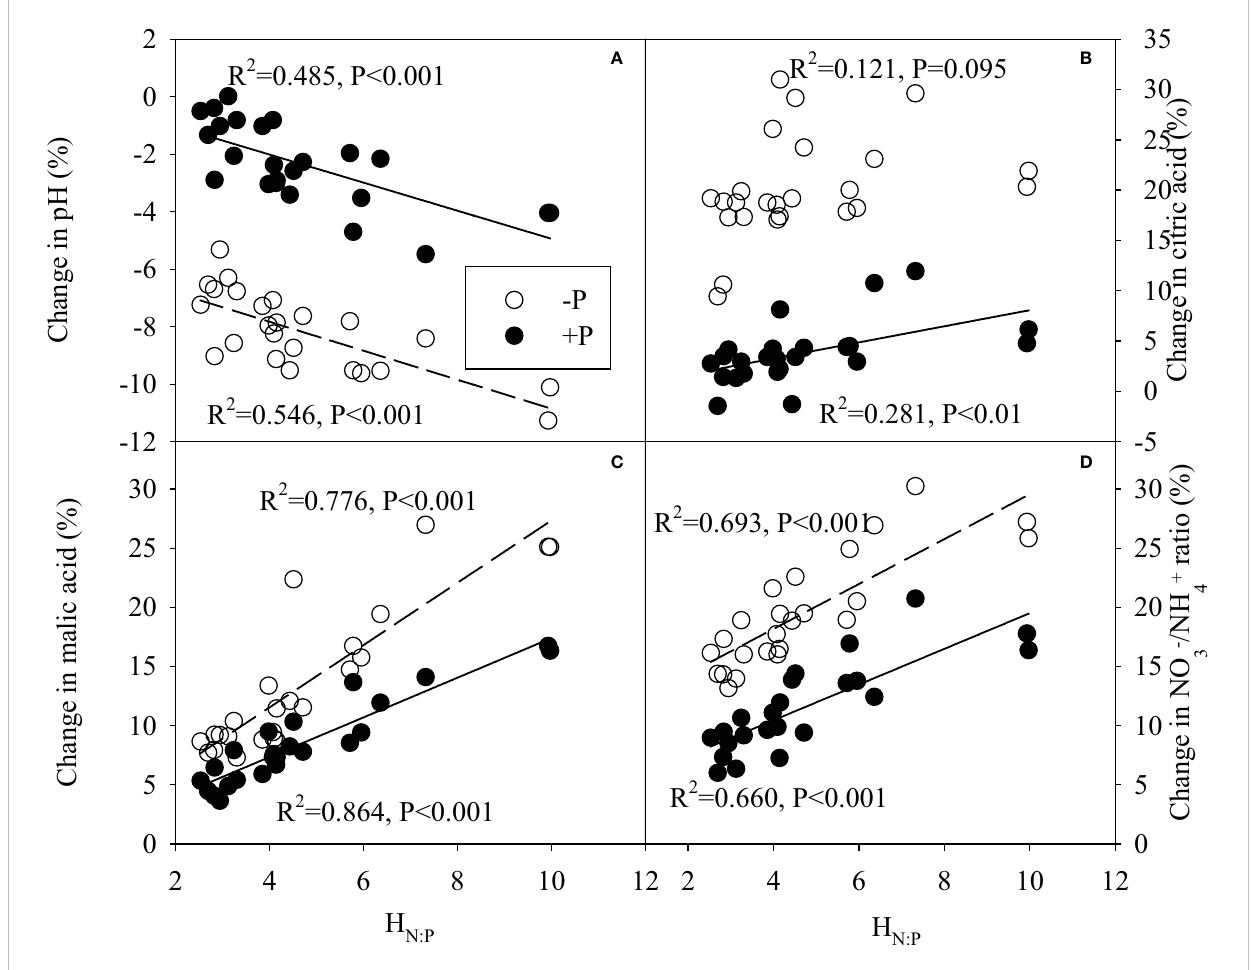
FIGURE 7 Correlation relationships between stoichiometric homeostasis of plant N:P (H N:P ) of legume species and its change in pH (A) , citric acid concentration (B) , malic acid concentration (C) or NO − 3 /NH + 4 ratio (D) in rhizosphere under N addition with or without P